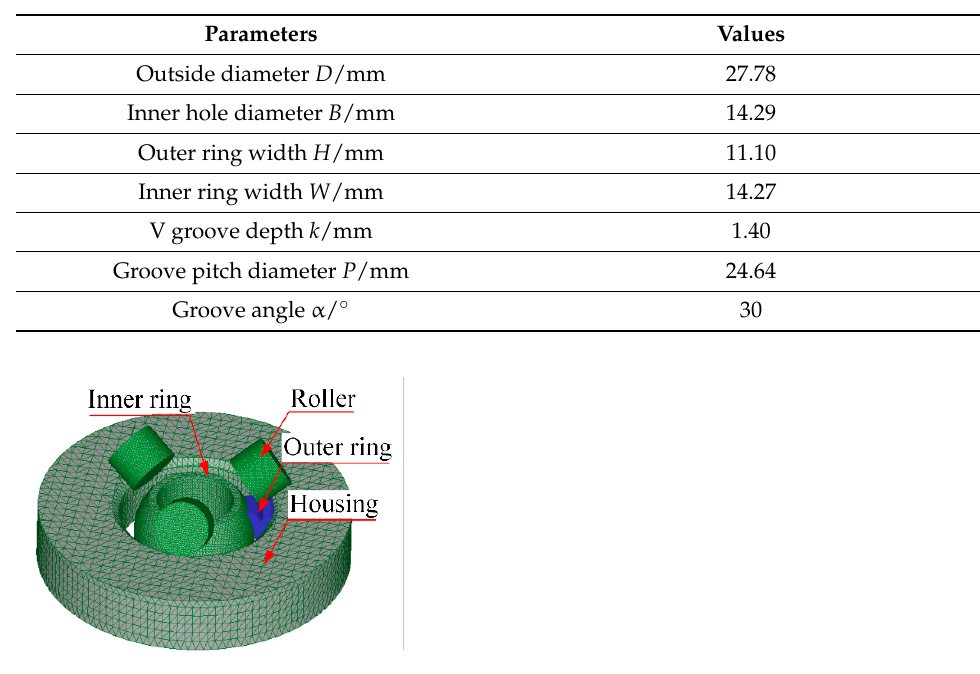
Table 2. The details of the numerical